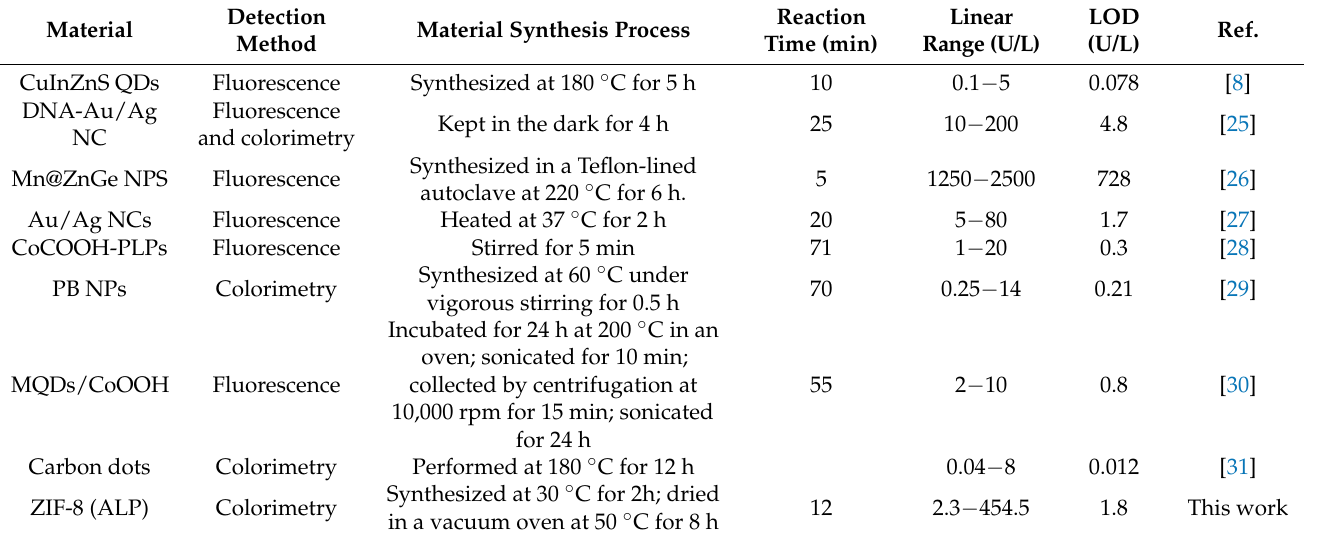
Table 2. Comparison of the previously reported methods and present work for the detection of